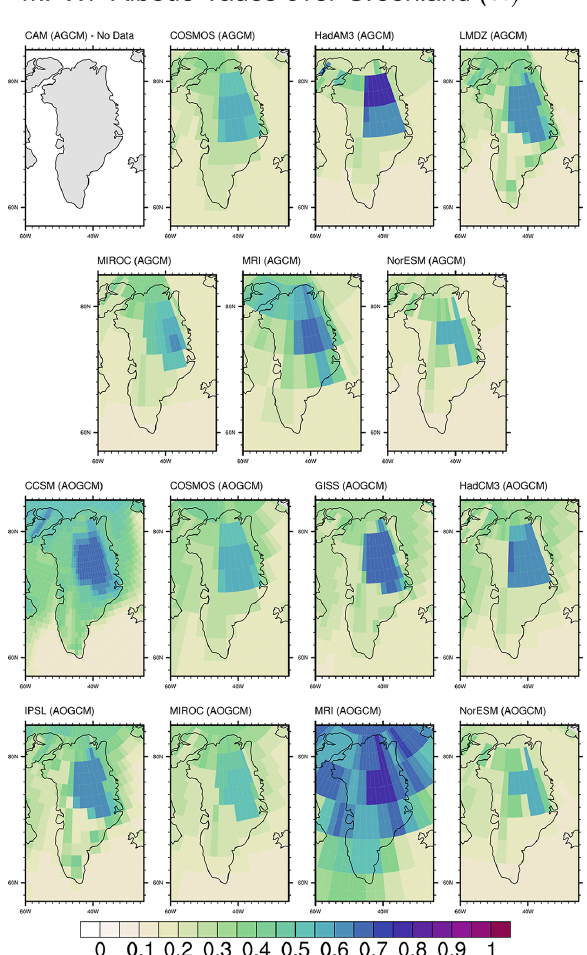
Figure 11. mPWP annual mean clear sky albedo values over Green- land for PlioMIP models (where